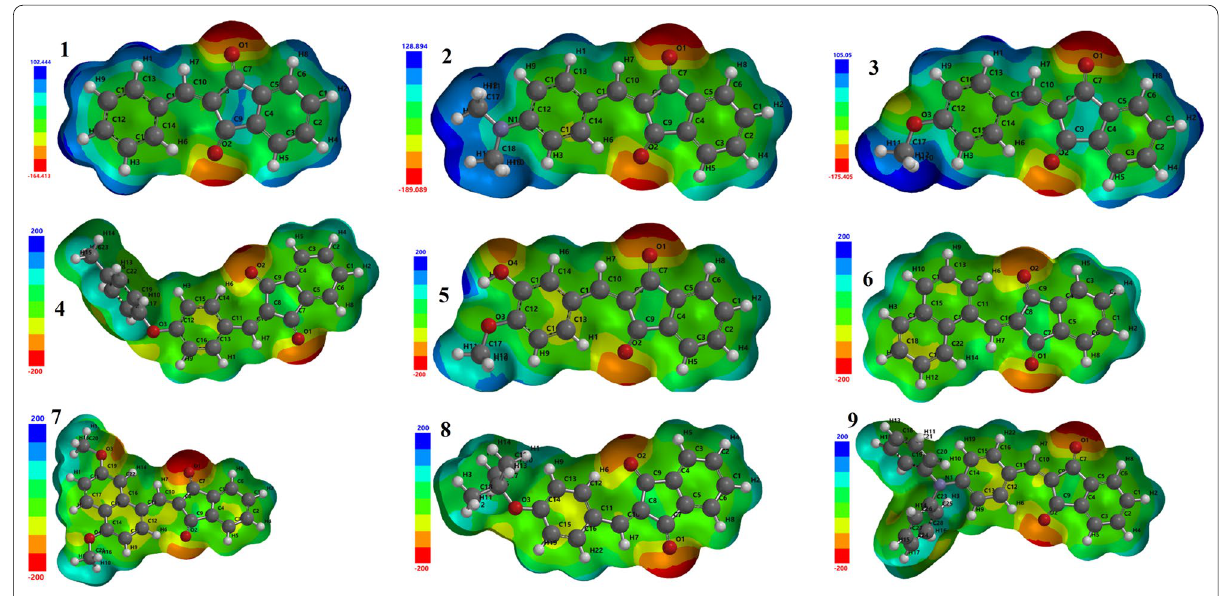
Fig. 3 Molecular electrostatic potential (MEP) map of Compounds 1 to 9